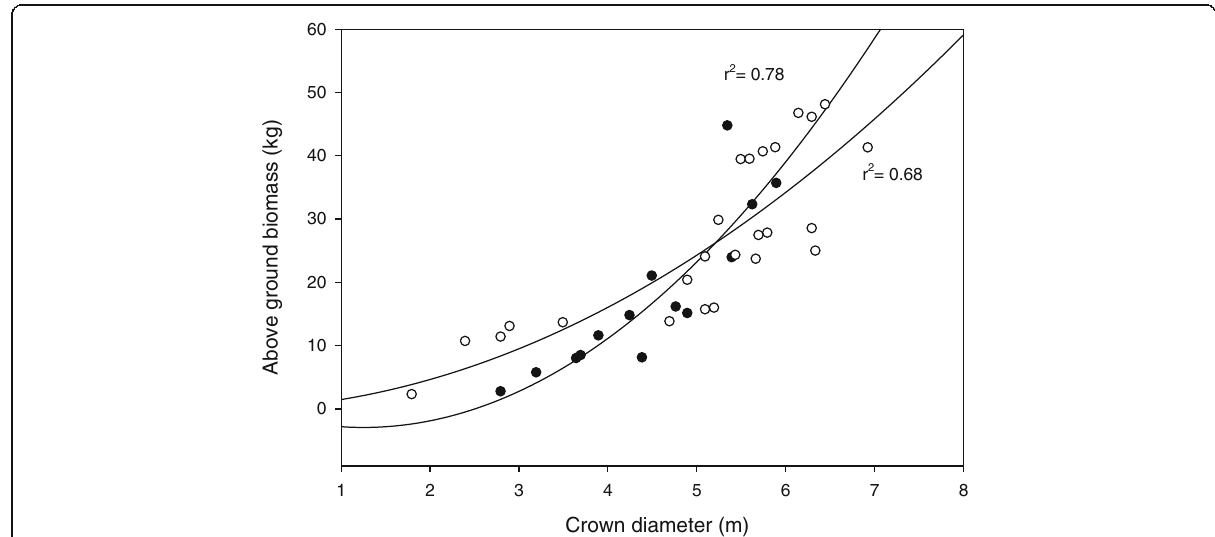
Fig. 4 Regression lines of total dry biomass (in kg) versus Crown diameter (CD) (open circles) for Juniperus procera and (filled circles) for Acacia abyssinica